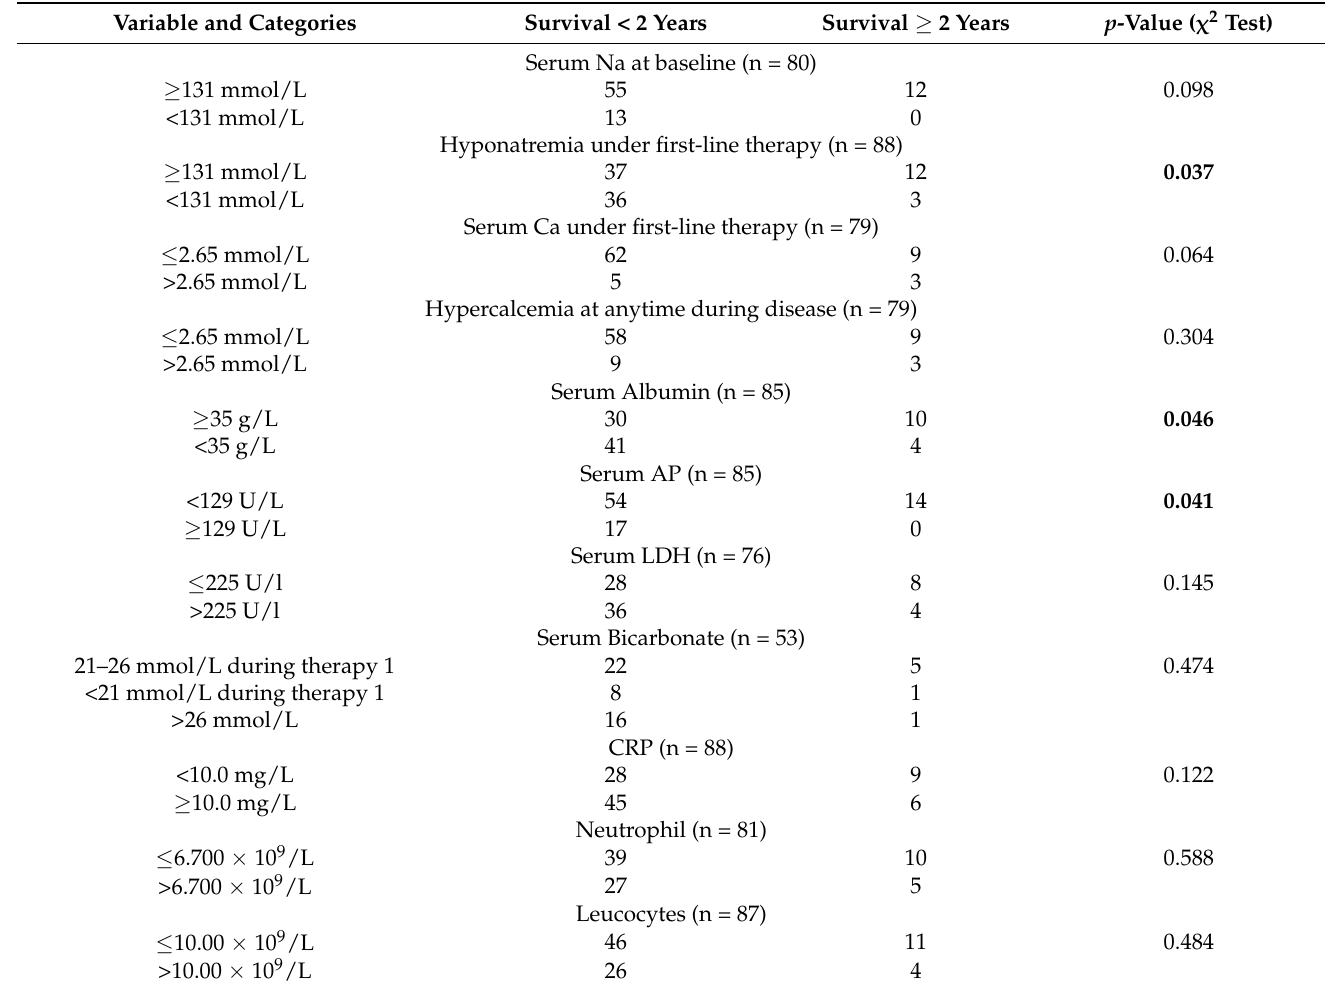
Table 6. Baseline laboratory parameters and their correlation to long-term